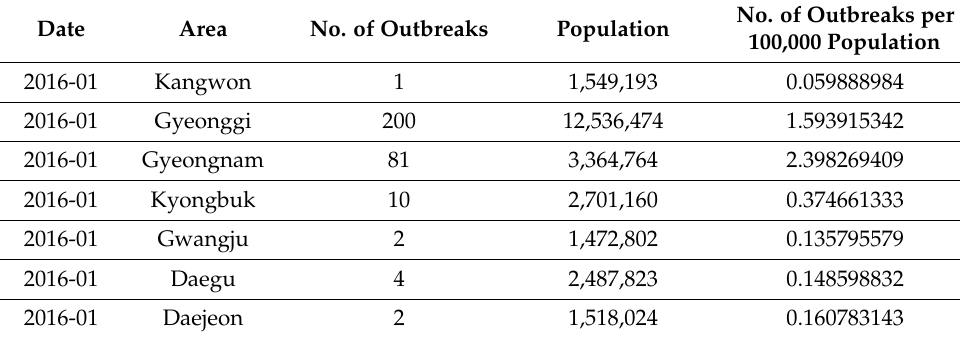
Table 4. Epidemic outbreaks to the number of outbreaks per 100,000 population.